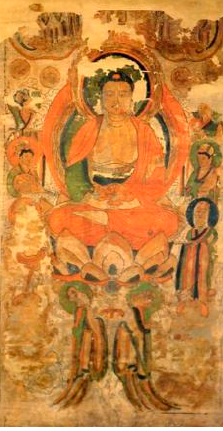
Figure 4. Chishengguang jiuyaotu 熾盛光九曜圖 (Tejaprabh ā Buddha Subduing the Nine Lumi ‐ naries), Historical Relics Preservation Institute of Yingxian Wooden Pagoda 应县木塔文保所 , Hand ‐ colored woodblock print, 50 cm × 94.6 cm, Liao period, ca. 1000.